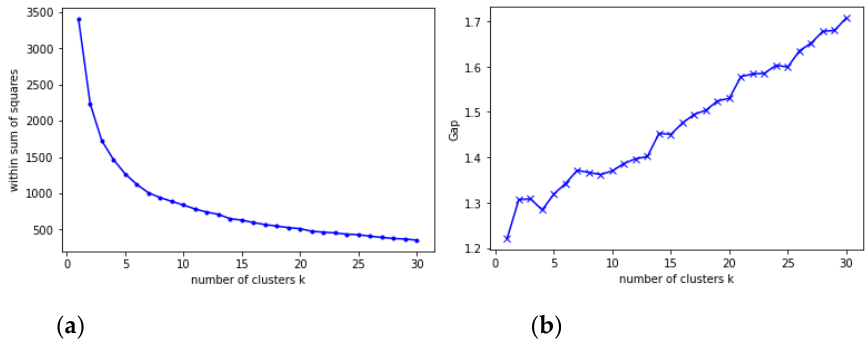
Figure 1. Results for ( a ) the within sum of squares and ( b ) the gap curve.